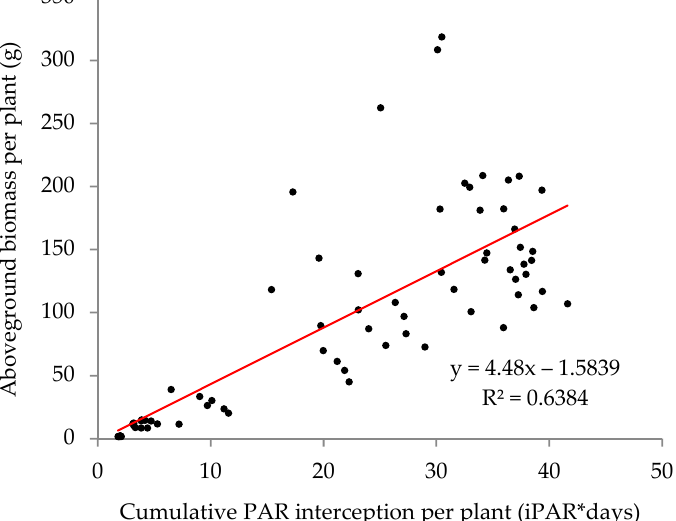
Figure 6. Relationships and fitted models between iPAR per plant and aboveground biomass per plant in 2019 and 2020. iPAR*days means iPAR’s integral of the number of growth days. There was a logarithmic relationship between the population cumulative iPAR and LAI (Supplementary Materials Figure S7), and the R 2 value was 0.91. There was a sig- nificant linear relationship between the population cumulative iPAR and plant height (Supplementary Materials Figure S7), with an R 2 value of 0.88. There was a significant linear relationship between the population cumulative iPAR and the population biomass (Figure 7), with an R 2 value of 0.93. The population cumulative iPAR and boll number showed a significant linear relationship in two years (Figure 7), with R 2 values of 0.92 and 0.76, respectively. There was a significant linear relationship between the population cumulative iPAR and boll weight in two years (Figure 7), with R 2 values of 0.53 and 0.90, respectively.